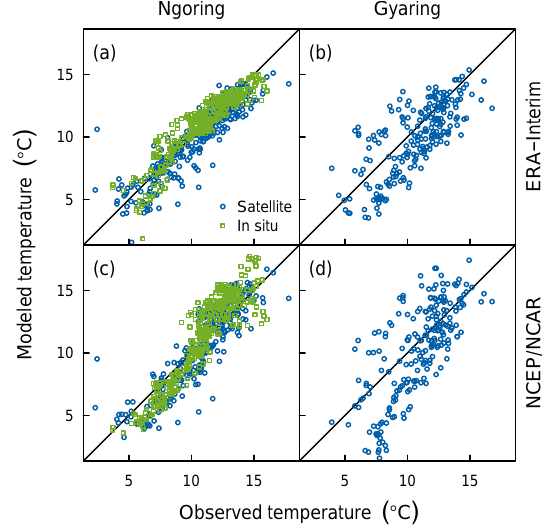
Figure 5. A comparison of the observed and modeled lake sur- face temperatures in Ngoring (a, c) and Gyaring (b, d) forced by the ERA-Interim reanalysis (a, b) and the NCEP/NCAR reanaly- sis (c, d) . The blue circles are derived from satellite data and the green squares from in situ measurements. Only the values from May to October are